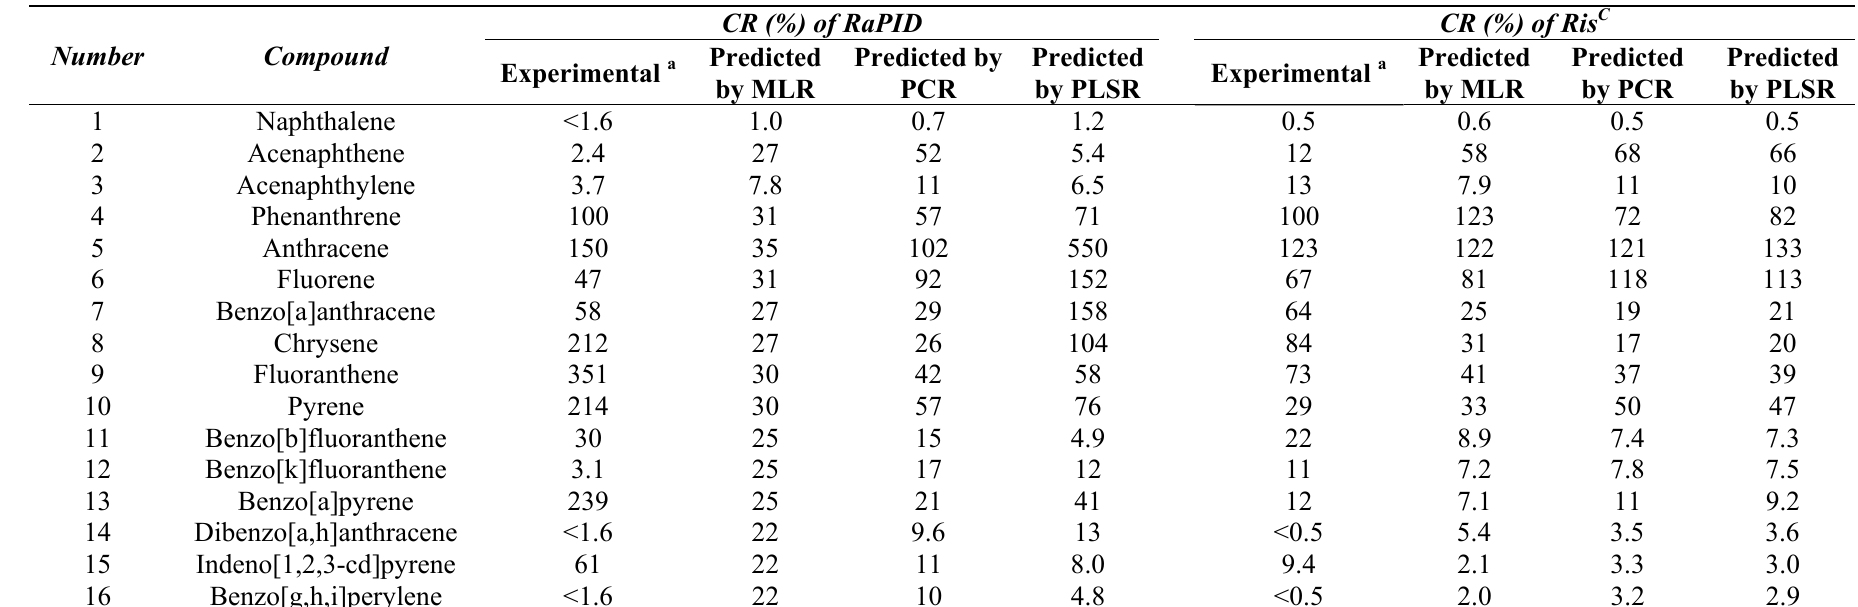
Table 2. Experimental and predicted cross-reactivity (CR) of the PAHs ELISAs by regression